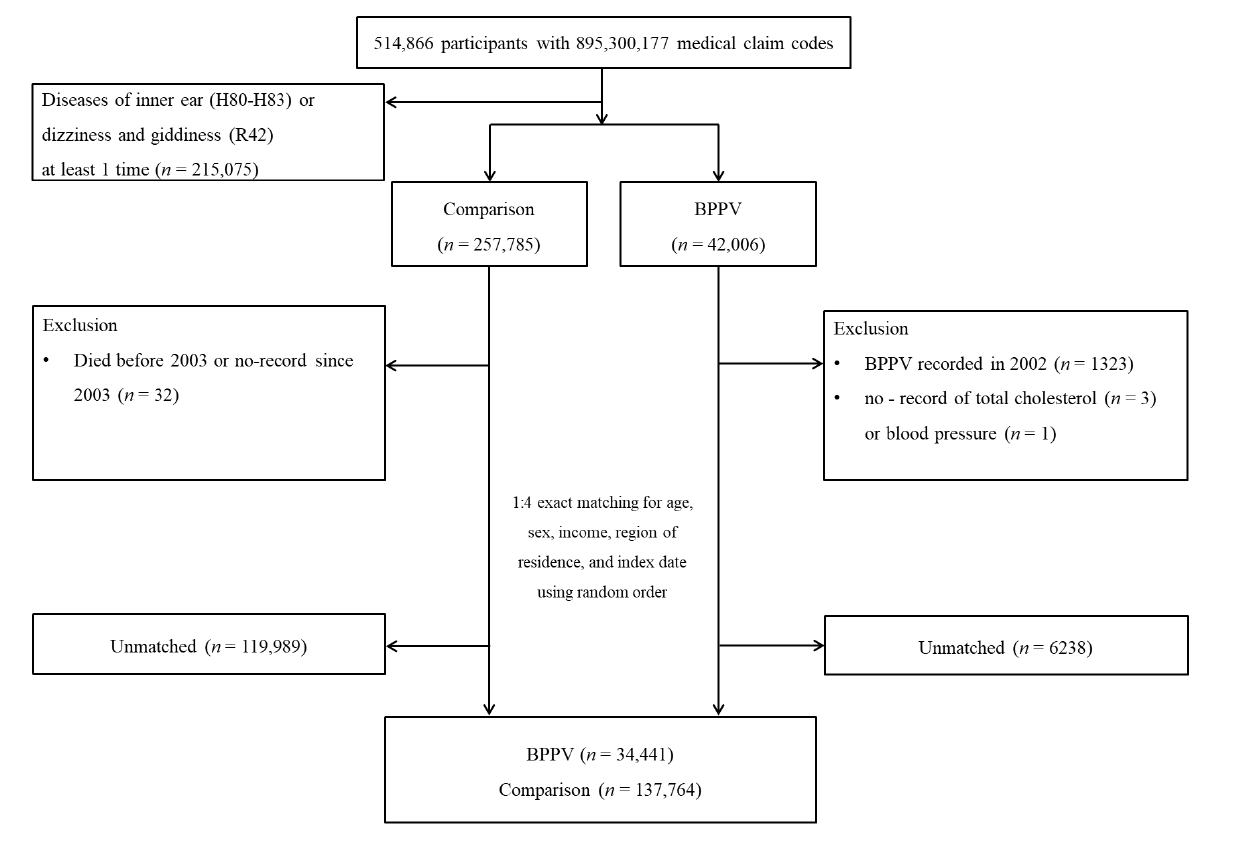
Figure 1. A schematic illustration of the participant selection process used in the present study. Of a total of 514,866 participants, 34,441 BPPV participants were matched with 137,764 comparison participants for age, sex, income, and region of residence.